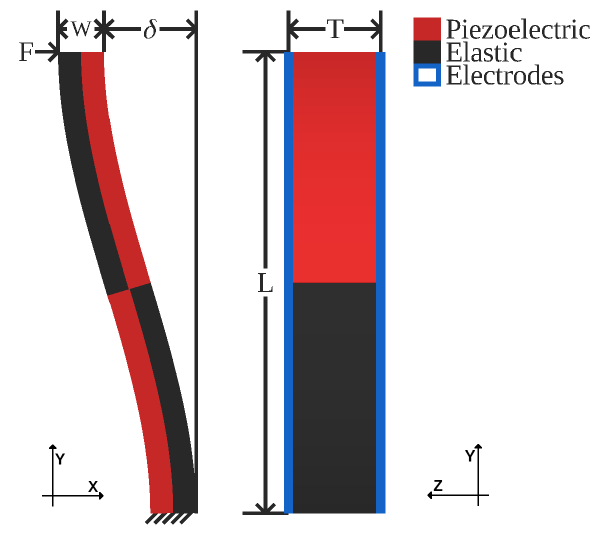
Figure 1. Geometry of a single actuated s-drive. F = load force, W = width, δ = deflection, T = thickness, and L = length. Electrodes omitted in XY view for